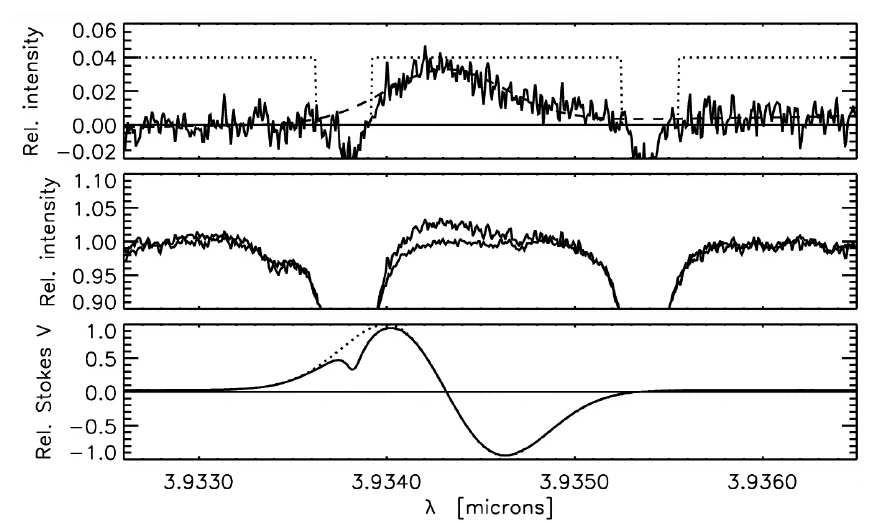
Figure 19: A spectrum of the 3934 nm [Si ix ] coronal emission. The top panel shows the observed coronal spectrum with the emission line fit with a Gaussian line profile; the middle panel shows the coronal spectrum and a disk spectrum for reference; and the bottom panel shows a graph approximating the expected Stokes V profile for this line. Image reproduced with permission from Judge et al. (2002), copyright by